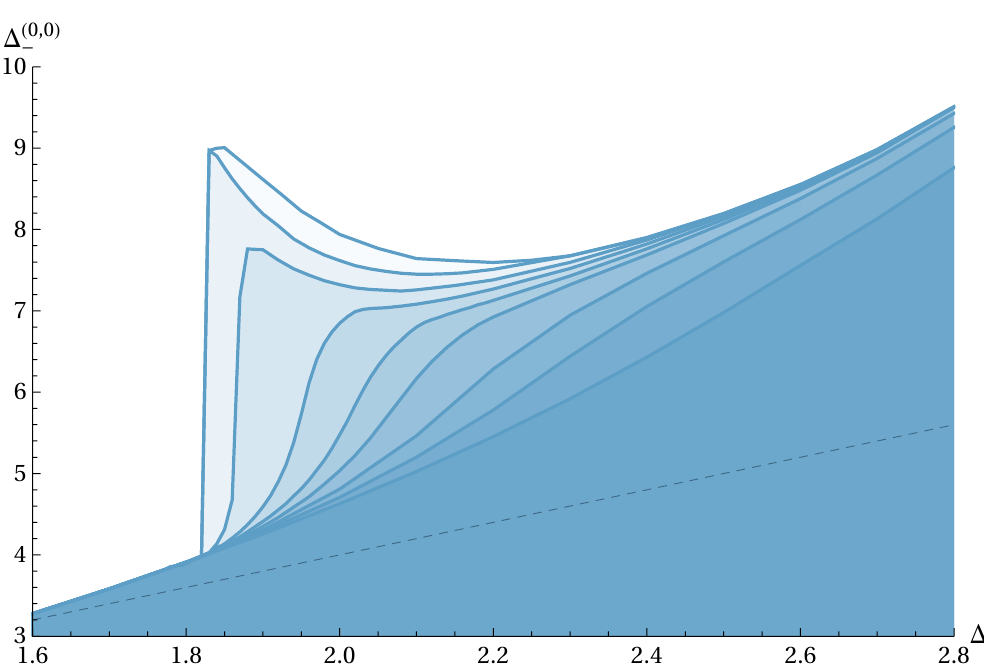
Figure 9 . Upper bound on the (cid:12)rst charged scalar assuming a gap on the (cid:12)rst charged (1 ; 1) operator, namely (cid:1) (1 ; 1) (cid:21) 3 + gap. The values of the gaps 0, 0.1, 0.2, 0.3, 0.4, 0.5, 0.7, 1.0 and 2.0 (cid:0) correspond to the regions from lighter to darker colors respectively. The bounds are computed at (cid:3) = 16.